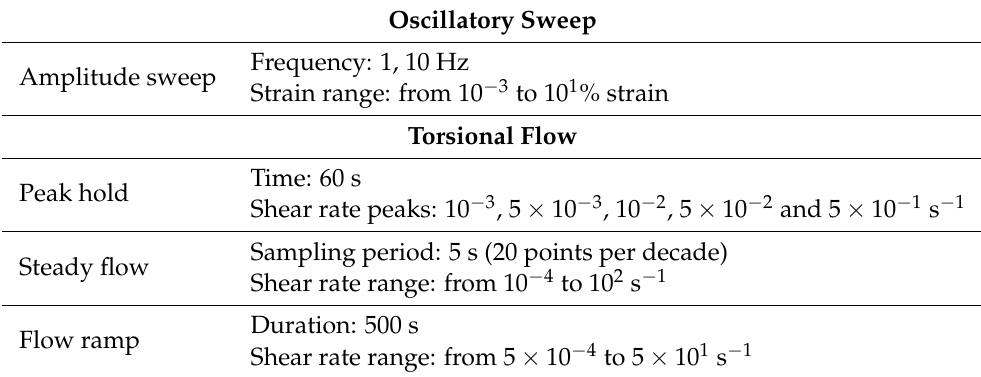
Table 1. Test parameters of the rheological